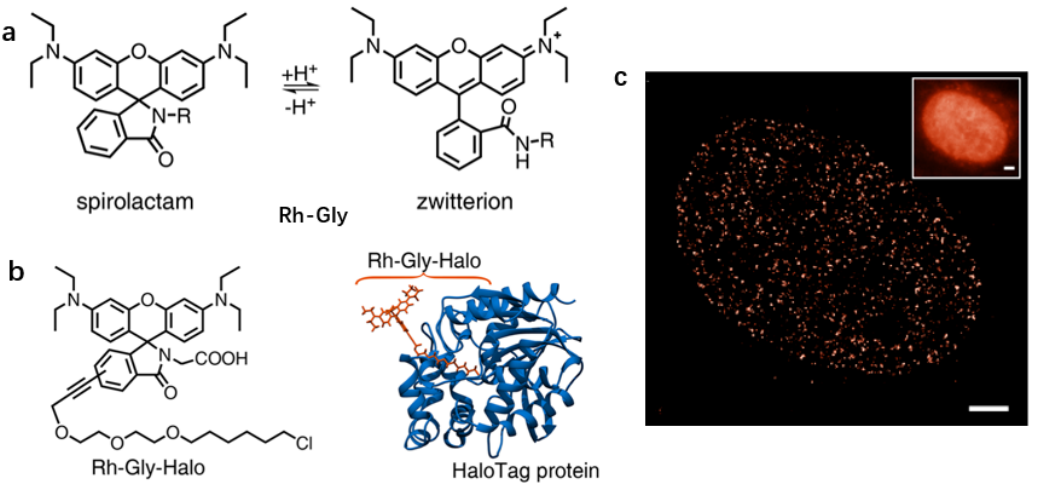
Figure 19. ( a ) Spontaneous spirocyclization equilibrium of rhodamine spirolactam. ( b ) Left: molecu- lar structure of Rh-Gly-Halo; right: model of HaloTag protein covalently bounded to Rh-Gly-Halo. Image of Rh-Gly-Halo coupled haloalkane dehalogenase (1BN6) is designed with Chimera. ( c ) PALM image of H2B-Halo fusion proteins labeled with Rh-Gly-Halo in a live HeLa cell under inclined illumination. Inset shows the wide-field image of the same H2B-Halo fusion proteins labeled with Rh-Gly-Halo. Reproduced from [66] with permission from the American Chemical Society, Copy- right